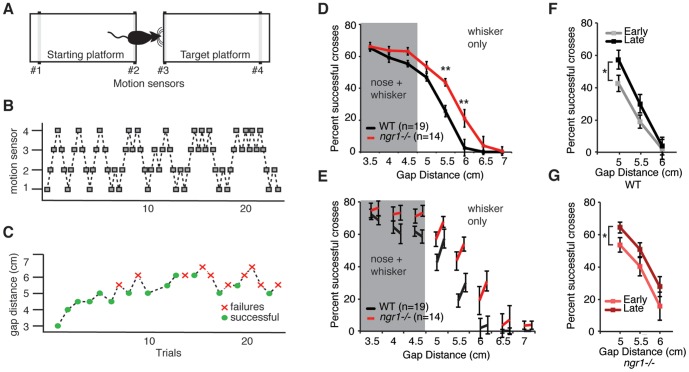
Mice lacking ngr1 perform better on the gap cross assay but display normal tactile learning across sessions.(A) A schematic of the gap cross assay. The movement of a mouse from the starting, or ‘home’, platform to the target platform across a given gap distance is detected with motion sensors positioned at the back and edge of each platform. (B) Activation of each sensor (grey box) indicates the position of the mouse. (C) Successful crosses are defined as the movement of the mouse from the starting platform to the target platform (green circles). Failures are defined as trials in which the mouse approaches the edge of the home or target platform and returns to the back of the home platform (red crosses). (D) ngr1−/− mice cross ‘whisker’ distances at a significantly higher success rate (WT, n = 19; ngr1−/−, n = 14; p>.01 for distances 5.5 and 6 cm; p>.32 for distances 3.5 and 4 cm, two-way ANOVA). This greater success rate is most significant at longer distances, 5.5 cm and 6 cm (**, p>.01 with Bonferroni correction for multiple comparisons). (E) Despite better overall performance, the percent improvement for a given gap distance from the first 4 sessions (left value for each distance) to the second 4 sessions (right value for each distance) is similar for WT and ngr1−/− mice for a given gap distance. (F) WT mice improve with experience at ‘whisker’ gap distances (WT, n = 19, *, p<.05, two-way repeated measures ANOVA) from the first 4 sessions (Early, grey line) to the second 4 sessions (Late, black line). (G) Ngr1 mutant mice improve with experience at ‘whisker only’ gap distances (ngr1−/−, n = 14, *, p<.05, two-way repeated measures ANOVA) from the first 4 sessions (Early, pink line) to the second 4 sessions (Late, red line).